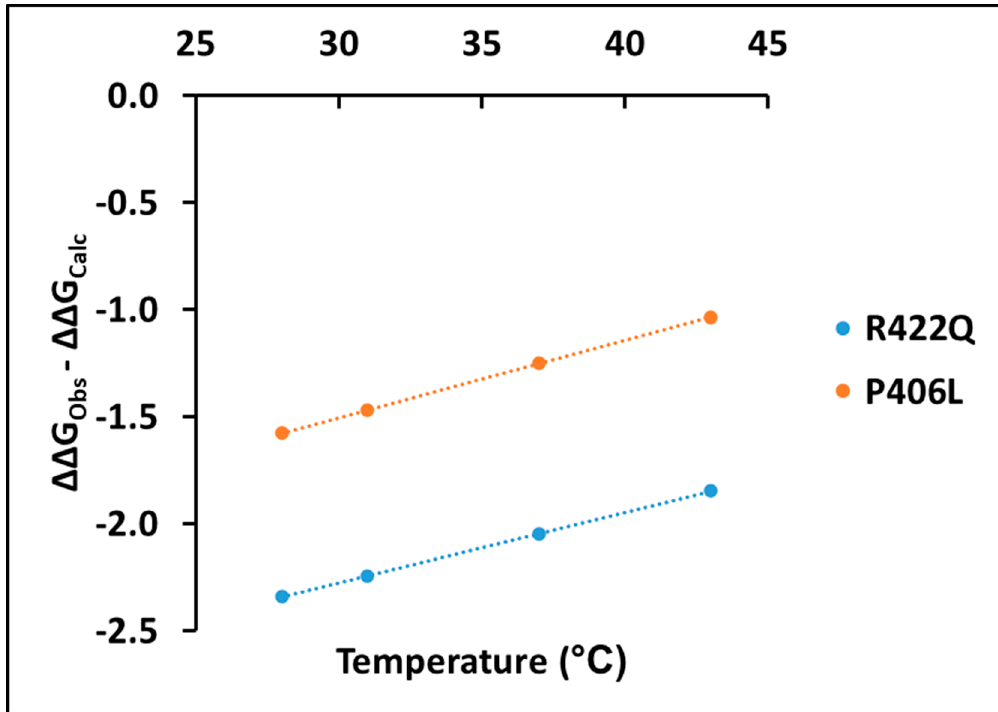
Figure 7 : The difference between experimental ΔΔ G Obs and computational ΔΔ G Calc as a function of temperature (°C). Here, ΔΔ G represents the free energy change obtained by subtracting the Δ G of the WT from the Δ G of mutant variants at different temperatures. The blue (E = 0.033T − 3.265, R 2 = 1.000) and orange ( E = 0.036T − 2.583, R 2 = 1.000) lines are for R422Q and P406L, respectively.